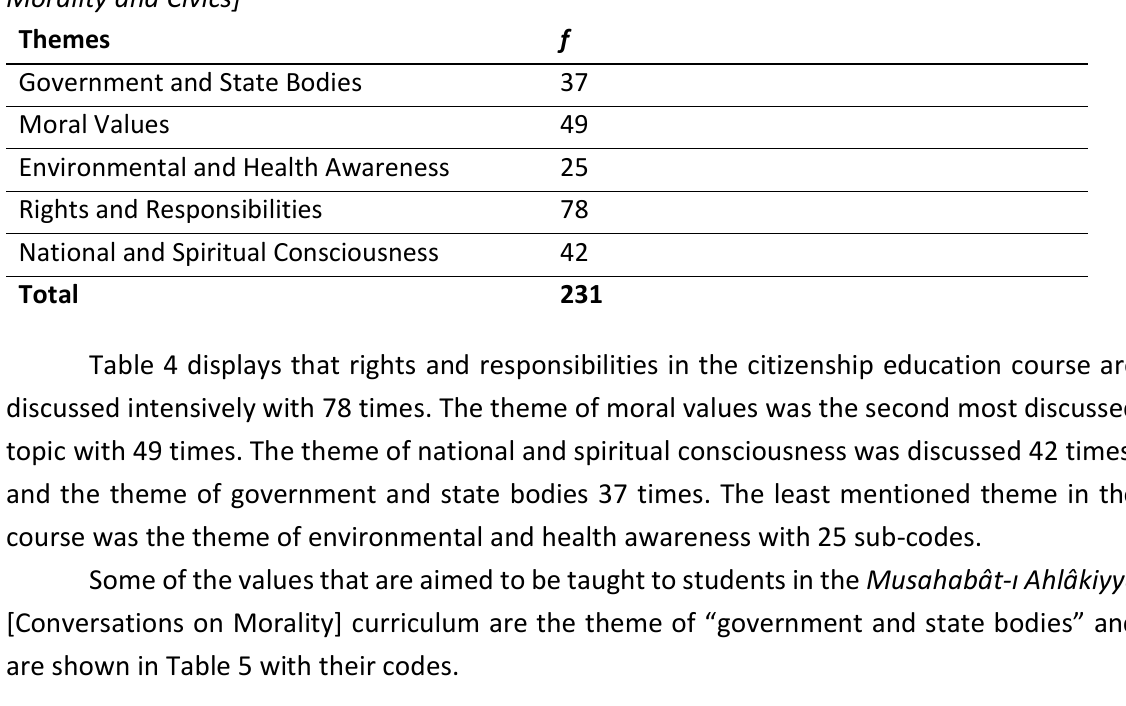
Table 5. Codes and Statistics of Government and State Bodies